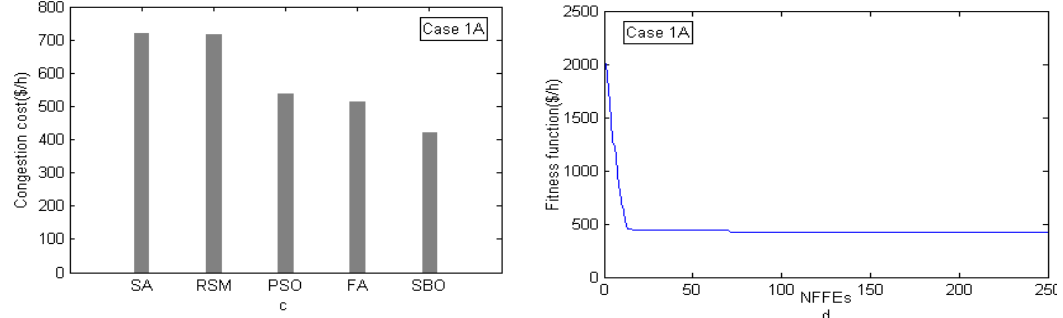
Figure 1. Simulation results for Case 1A. ( a ) voltage magnitude in p.u.; ( b ) change in real-power in MW; ( c ) congestion cost in $/h; ( d ) Convergence profile.